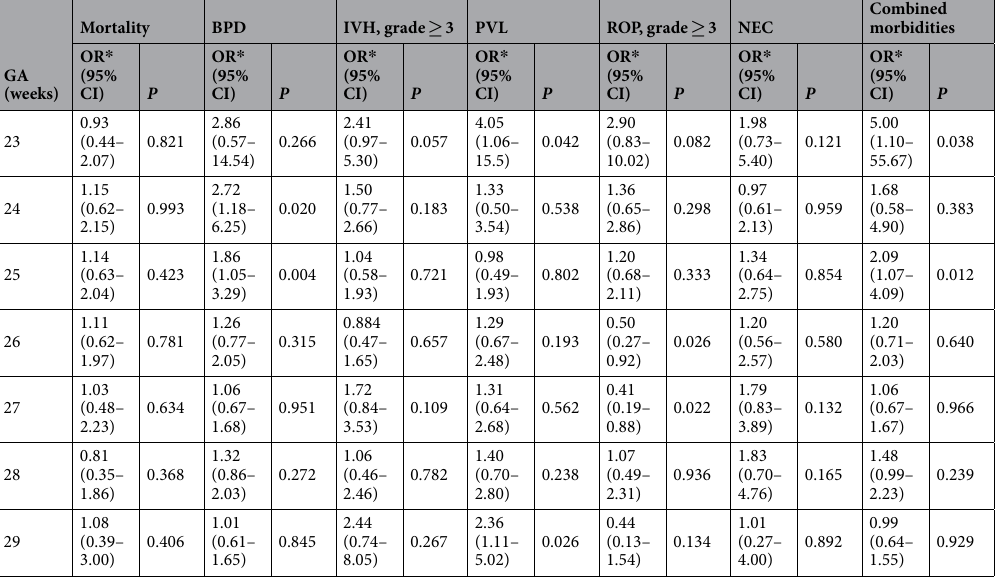
Table 4. Sex difference for the occurrence of mortality and the prevalence of major neonatal morbidities, stratified by individual gestational age. * Values are adjusted odds ratio and 95% confidence interval. Values are adjusted by histologic chorioamnionitis, intrauterine growth restriction, maternal diabetes, maternal hypertension, multiple births, delivery mode, and the use of antenatal steroid according to individual gestational age